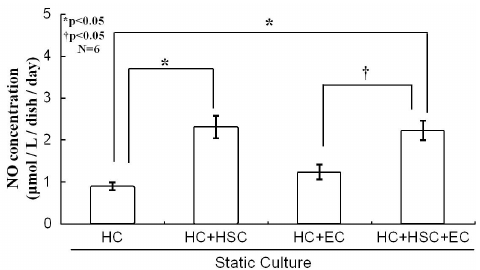
Fig. 5 Nitric oxide (NO) concentration in static culture. NO concentrations in the HC+HSC and HC+HSC+EC models were higher than in the HC model; the concentrations in the HC+EC and HC models were similar to one another. Data are presented as the means ± SD. *p<0.05 versus HC model; †p < 0.05 versus HC+EC